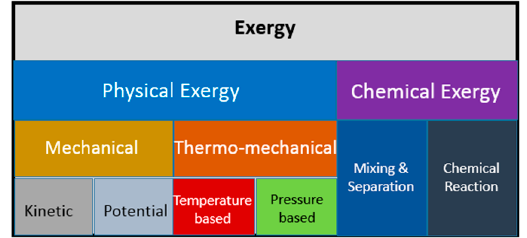
Figure 2. Exergy flows in a process stream, after [21].